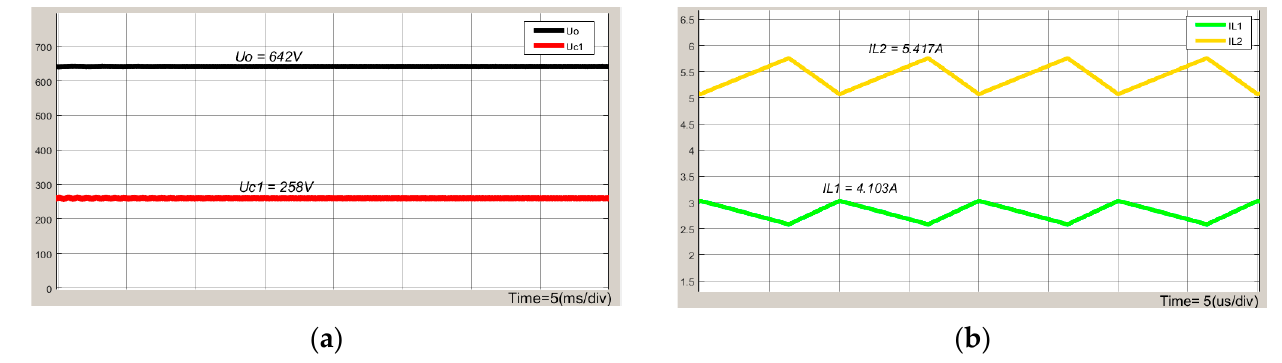
Figure 8. The simulation results of state 1 and 2: ( a ) the voltages of output and capacitor in state 1; ( b ) the average currents and their waveforms of inductors L 1 and L 2 in state 1; ( c ) the voltages of output and capacitor in state 2; ( d ) the average currents and their waveforms of inductors L 1 and L 2 in state 2.